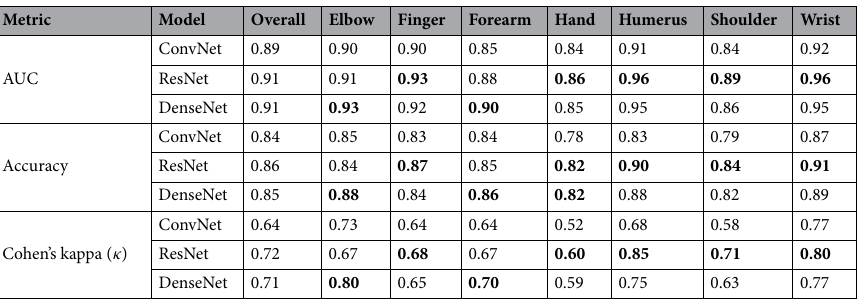
Table 5. Validation dataset performance of baseline models—overall and across different parts of body. Bold numbers indicate the highest performing model for each evaluation metric across eight studies. DenseNet is the designated learner for the Elbow and Forearm studies and ResNet for the remaining